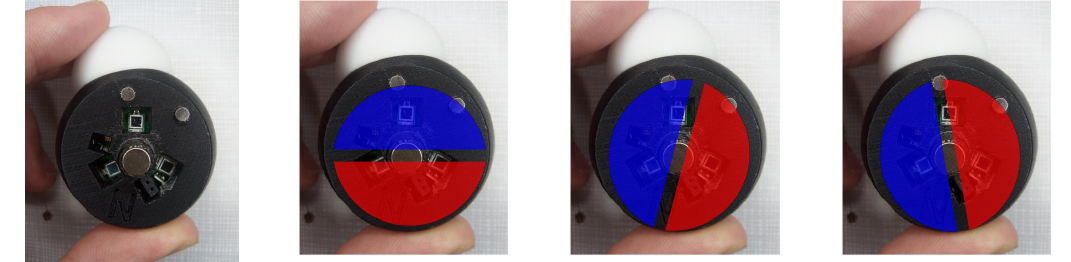
Figure 20. Unknown offset representations on an Alpha Carbon